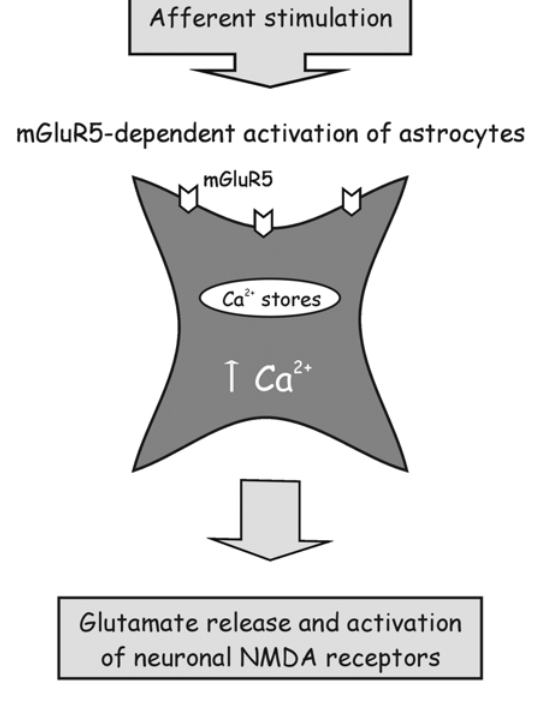
FIGURE 4 . mGluR5 receptors are key regulators of gliotransmission in the nucleus accumbens. Model depicting the sequence of steps leading to Ca 2+ -dependent gliotransmission. Spillover of glutamate following glutamatergic afferent stimulation results in the activation of astrocytic mGluR5 receptors, which generate sustained Ca 2+ oscillations into astrocytes. The oscillatory Ca 2+ signals trigger the release of glutamate from these cells, which activates neuronal NMDA